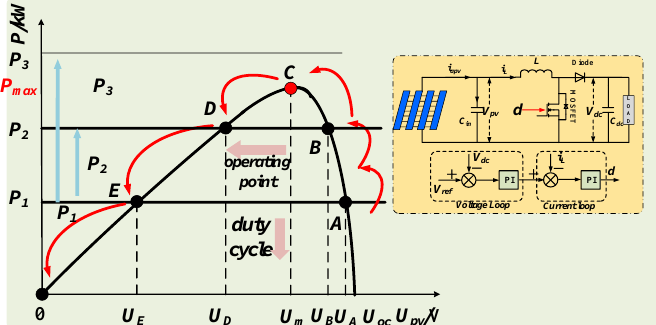
Figure 4. Illustration of working points of a PV power generation system. The inset depicts a circuit diagram of the system and a block diagram of the controller.